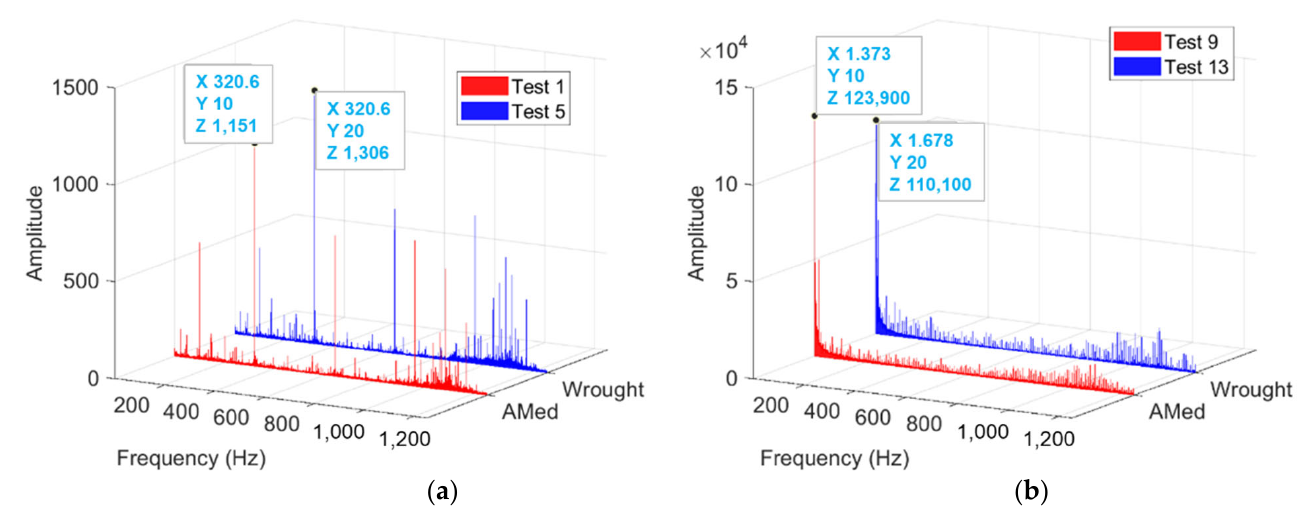
Figure 8. FFT of the signal of radial force when machining wrought and SLMed Ti6Al4V materials at the speed of 80 m/min and feed of 0.1 mm/rev: ( a ) at the cutting depth of 0.25 mm, ( b ) at the cutting depth of 0.5 mm.